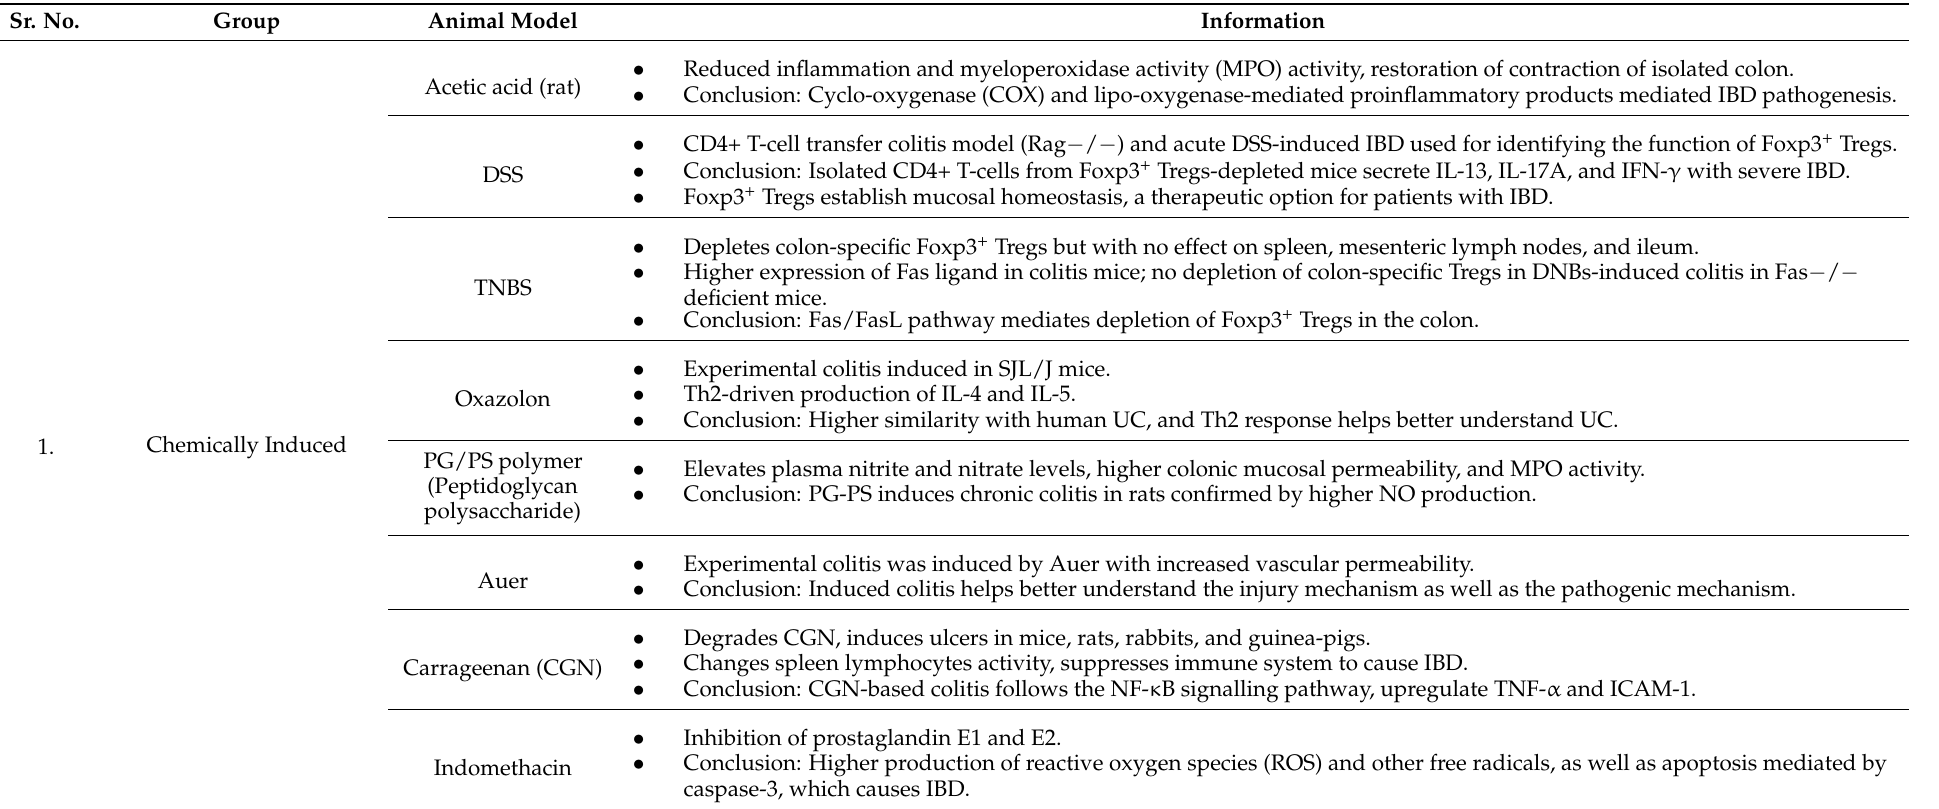
Table 1. The different types of animal model induced through various methods are summarized with their implication and role in IBD pathogenesis ([52,162]) (the generation of different genetically engineered mice are reviewed in detailed in [162,163]). Sr. No.